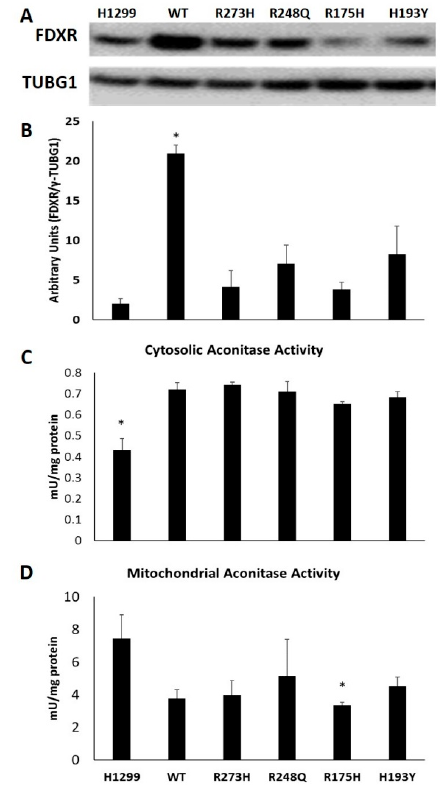
Figure 6. Impact of WT and mutant TP53 expression on Fe-S cluster biogenesis. Representative Western blot analysis of ferredoxin reductase (FDXR) expression in TP53 null cells (H1299) and following tetracycline induction of indicated TP53 expression types ( A ). FDXR protein quantitation following normalization to TUBG1 ( B ). Cytosolic ( C ) and mitochondrial ( D ) aconitase activity were also measured in the same cell types. * Denotes statistical di ff erence, p <